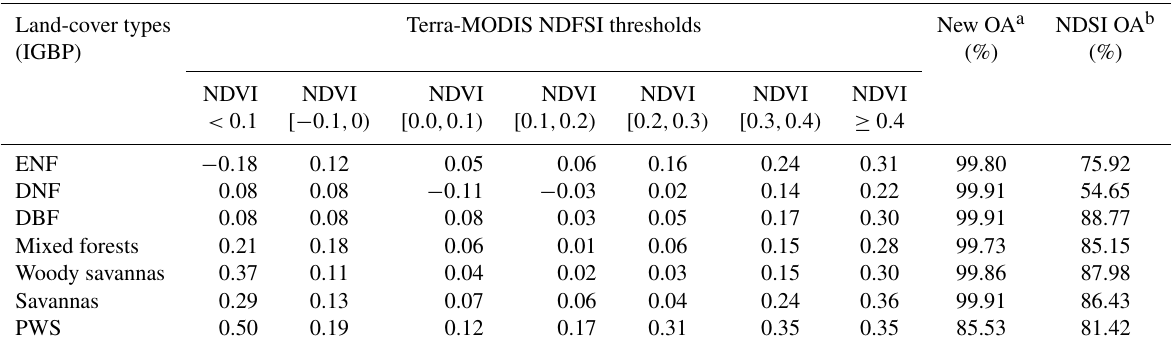
Figure 4. NDVI-NDFSI number-density scatterplot over “deciduous broadleaf forest” from Terra-MODIS training samples (colors represent the number density within a 0 . 01 × 0 . 01 bin). Table 2. Optimized Terra-MODIS NDVI-NDFSI decision rules for forest land-cover types (ENF: evergreen needleleaf forests; DNF: decid- uous needleleaf forests; DBF: deciduous broadleaf forests; PWS: permanent wetland